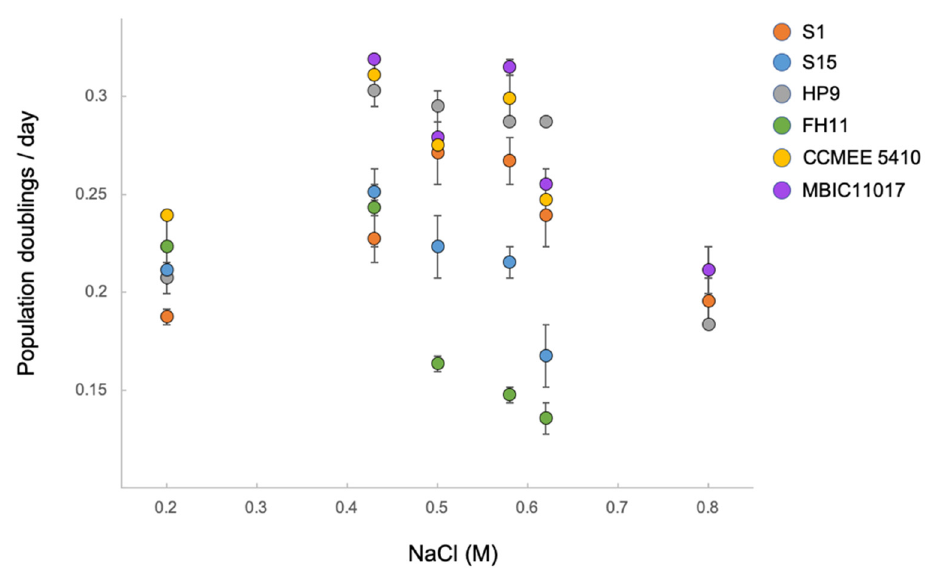
Figure 5. Population growth rates at different NaCl concentrations for upper intertidal A. marina strains S1 and HP9, subtidal strains S15 and MBIC11017, estuarine strain FH11, and saline lake strain CCMEE 5410. Error bars are standard errors. Note that 0.43 M is the NaCl concentration of standard marine ASN-III medium. Rates were estimated if growth was sustained for at least three generations. Pigments of strains for which growth was not observed at 0.2 M or 0.8 M NaCl did not bleach, whereas all strains bleached at 0 M and 1.6 M.